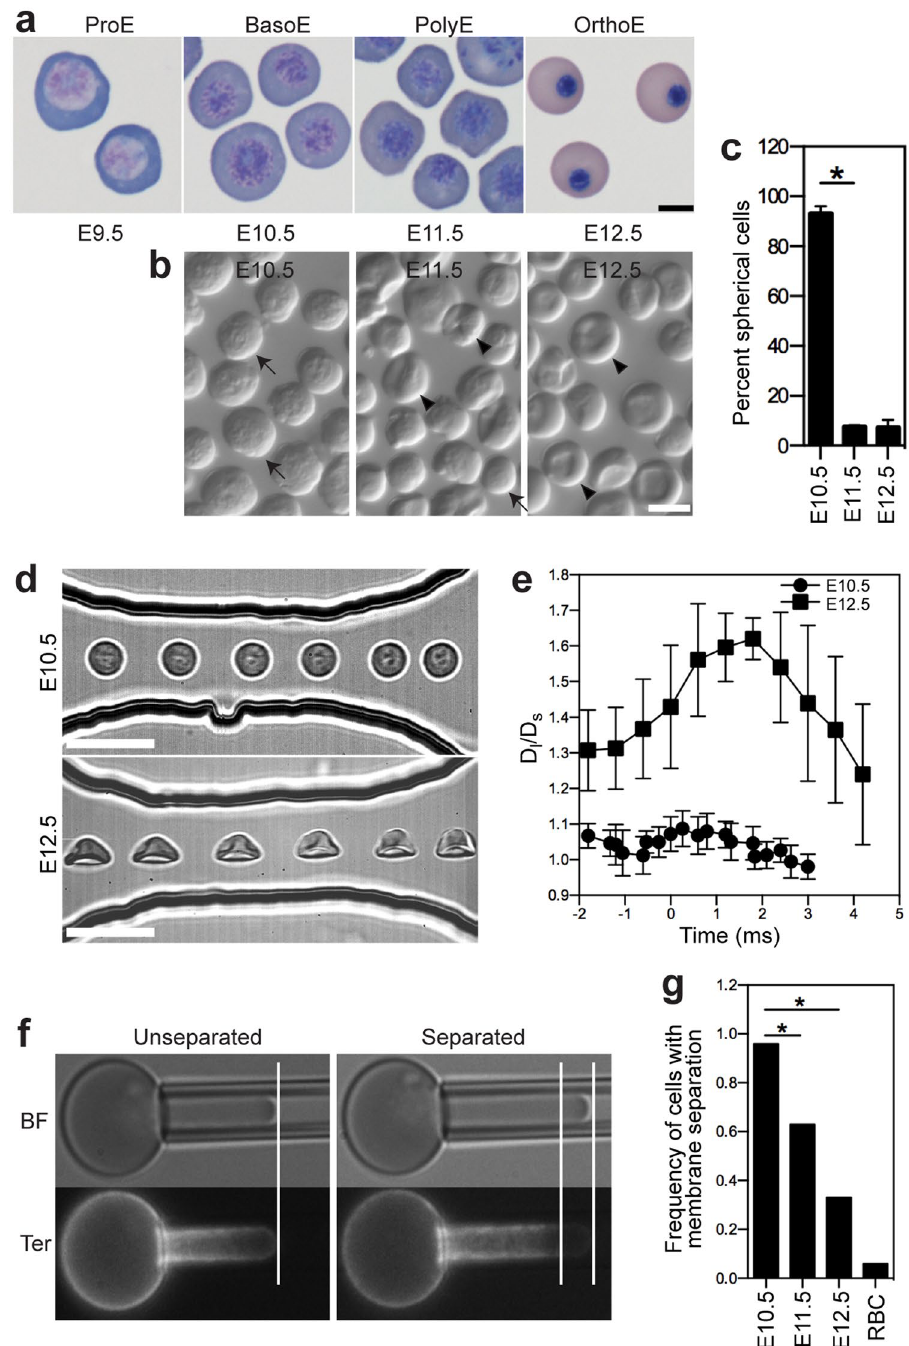
Figure 1. Primary primitive erythroblasts alter their cell shape, gain the capability to deform, and develop increasing mechanical stability as they transition from BasoE at E10.5 to OrthoE at E12.5. ( a ) Circulating primitive erythroblasts transition from ProE at E9.5 to OrthoE at E12.5 as a single cohort in the bloodstream. ProE, proerythroblasts; BasoE, basophilic erythroblasts; PolyE, polychromatophilic erythroblasts; PolyE/ OrthoE, polychromatophilic and orthochromatic erythroblasts; and OrthoE, orthochromatic erythroblasts. ( b ) Primitive erythroblasts alter their cell shape from spherical to partially concave as they progress from BasoE at E10.5 to OrthoE at E12.5. Freshly isolated fetal blood cells were visualized by light microscopy. Cells were identified as being spherical (arrows) versus partially concave (arrow heads). Scale bar represents 10 µ m. ( c ) The proportion of spherical primitive erythroblasts at different time points is quantified. Numbers represent at least 300 total cells per sample and error bars are SEM of three different independent experiments per stage. * p = 3.09e-6. ( d ) Images of primitive erythroblasts at the BasoE stage (E10.5) and the OrthoE stage (E12.5) in the microfluidic channel. Scale bar represents 20 µ m. ( e ) Aspect ratio (D l /D s ) changes of deforming primitive erythroid cells in the microfluidic channel. D l , cell length; D s , cell width. Time 0 indicates the time when cells enter the constriction channel. ( f ) Membrane mechanical stability of primitive erythroblasts was